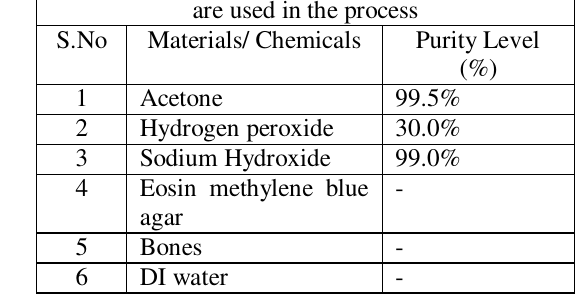
Table 1: The list of materials and chemicals that are used in the process S.No